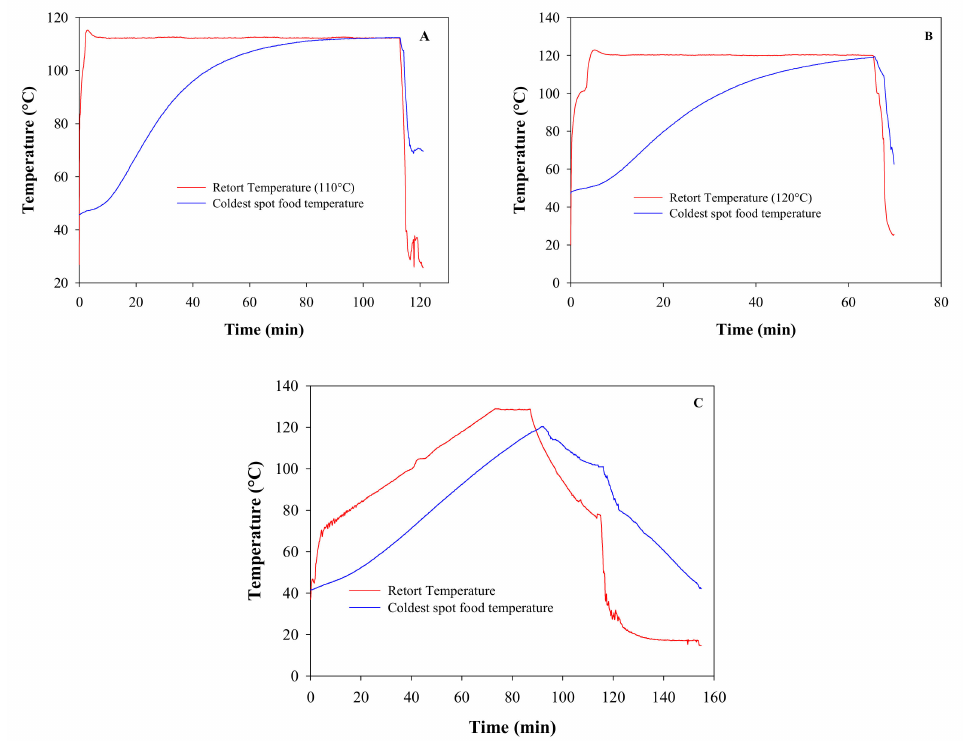
Figure 2. CRT and VRT profiles obtained from thermal sterilization of bentonite with gallic acid as the quality component at ( A ) 110 ◦ C, ( B ) 120 ◦ C and ( C ) VRT. Data source: Salgado et al.